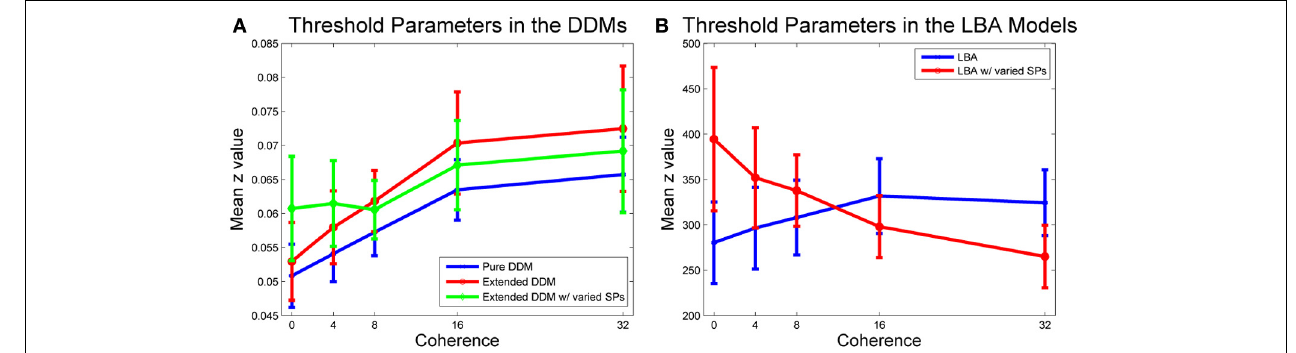
FIGURE 5 | Mean threshold values versus coherence. (A) Caution increases with coherence in all DDM fits. Pure (blue) and first extended DDM (red) fits do not differ significantly, but difficulty condition is significant [ F (4 , 64) = 3 . 91, p < 0 . 01, η 2 = 0 . 16]. Allowing the starting point range to vary in the second extended DDM (green) does not improve fits by AIC/BIC, but compared with the other two DDM fits, main effects of model [ F (2 , 32) = 3 . 99, p < 0 . 05, η 2 = 0 . 02] and interaction of model type